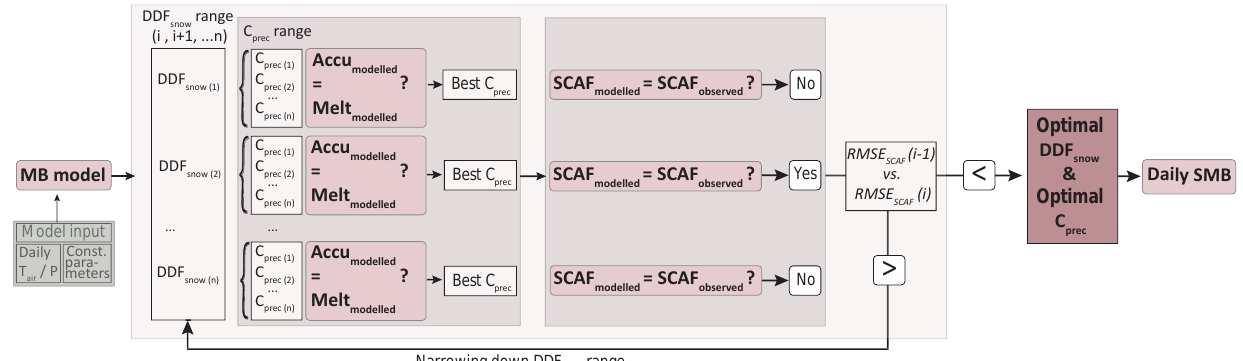
Figure 4. Calibration procedure to obtain an ideal combination of DDF snow and C prec . An initial range for DDF snow and C prec was narrowed down through a comparison with TSL observations until an optimal solution for both parameters was found. First, for each initial value of DDF snow , the best value of C prec was determined, constraining the modelled cumulative melt (Melt modelled ) at the TSL position to agree with the modelled winter snow accumulation (Accu modelled ) for the same location. Second, the performance of each DDF snow was evaluated to narrow down the range of DDF snow by comparing the RMSE SCAF of the modelled and observed snow-covered area fractions (SCAF). This was repeated until an optimal solution is